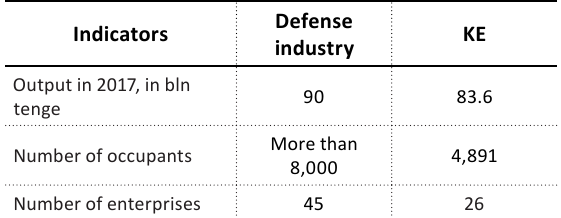
Table 1. Economic indicators of defense industry and KE Indicators Output in 2017, in bln tenge Number of occupants Number of enterprises 45